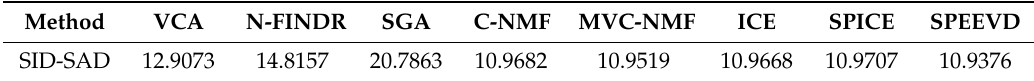
Table 7. The average SID-SAD between the extracted endmember and the USGS library